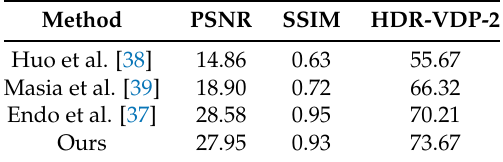
Table 2. The comparison with the start-of-the-art HDR prediction methods using different